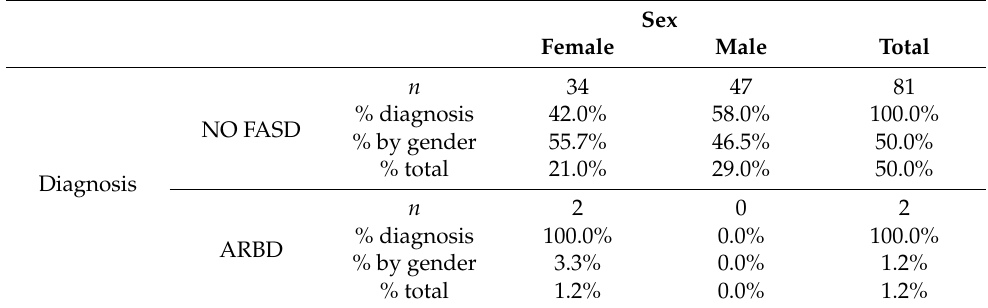
Table 3. Distribution by sex of the FASD diagnoses among Russian and Ukrainian adoptees in